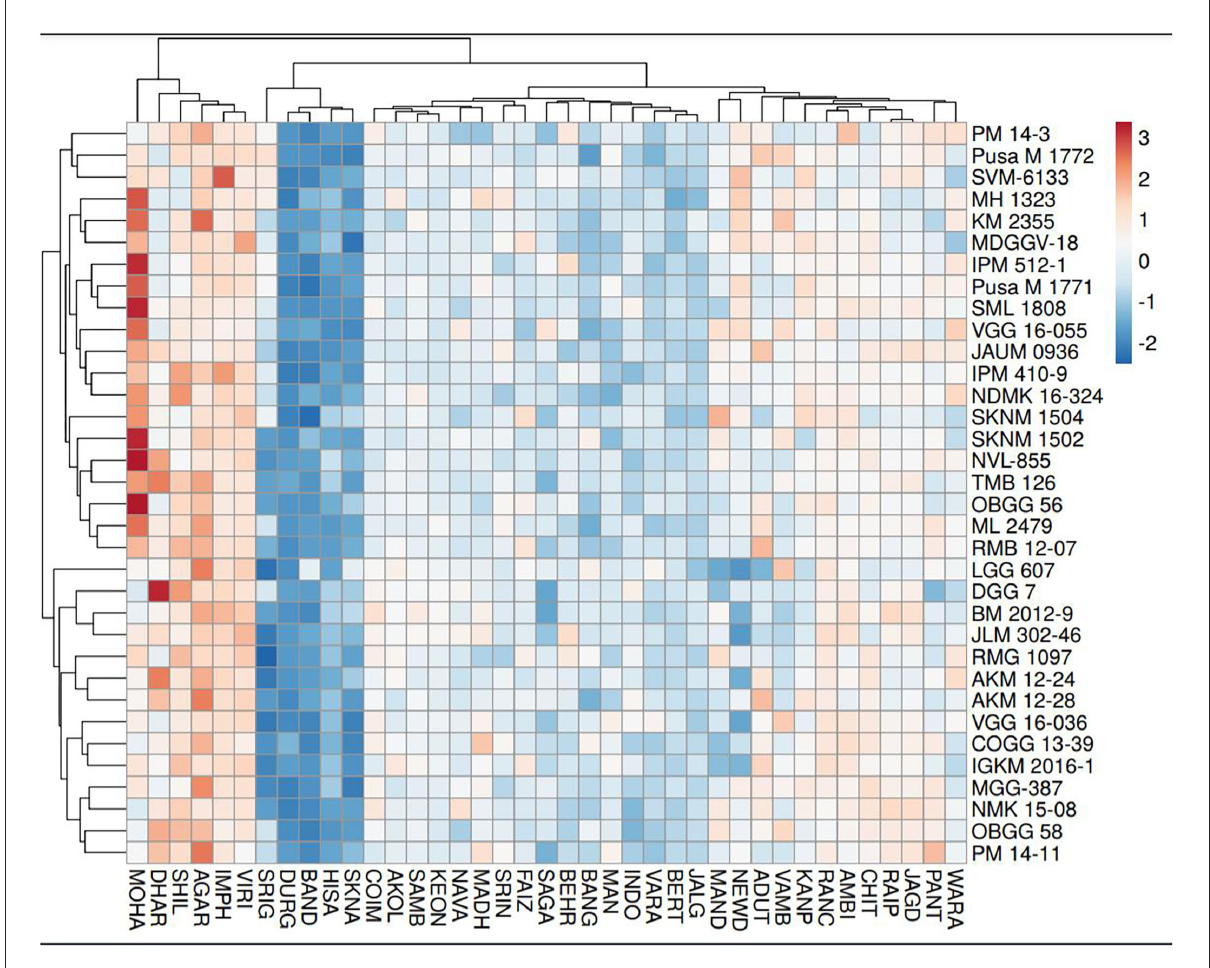
FIGURE8 Hierarchical cluster analysis explaining the relationship between mungbean genotypes ( n ( n =